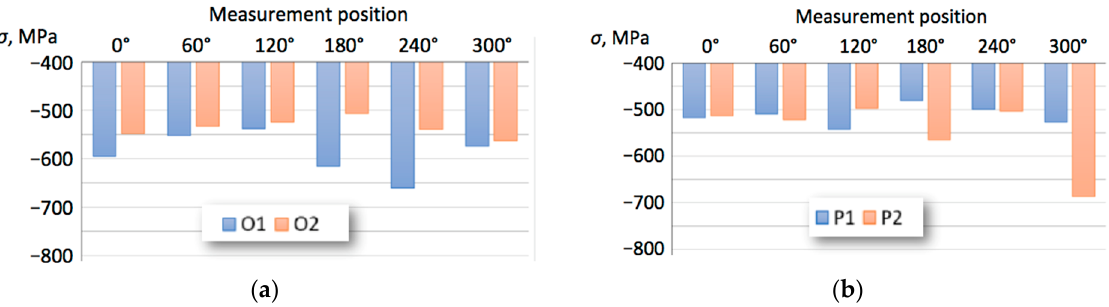
Figure 10. Comparison of normal residual stresses σ after machining with WIPER insert: ( a ) samples O1 and O2; ( b ) samples P1 and P2.